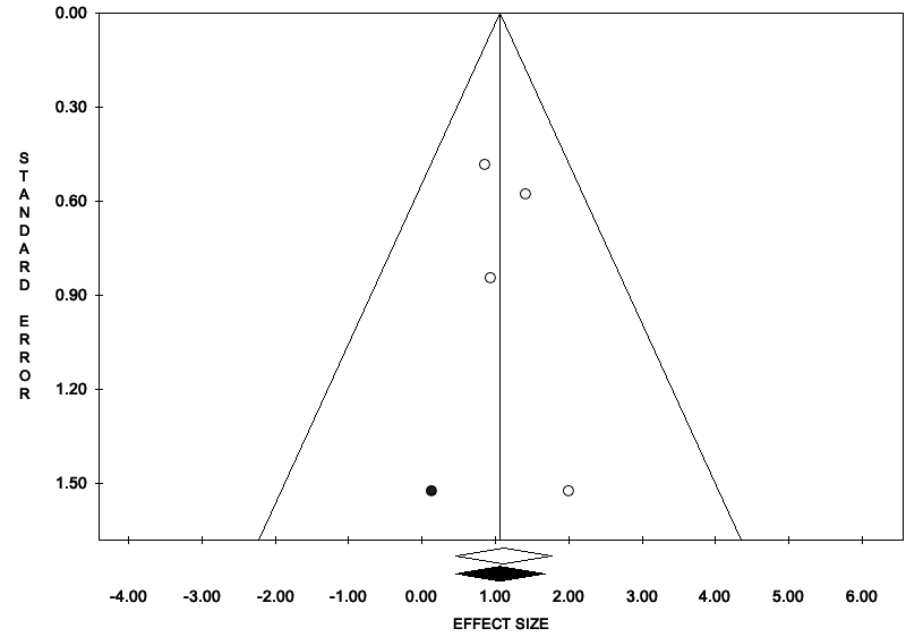
Figure 8. Funnel plots of the meta-analysis evaluating the OR for headache. Egger’s linear regression (t = 1, p = 0.42) and Begg and Mazumdar rank correlation test (z = 0.68, p = 0.497).